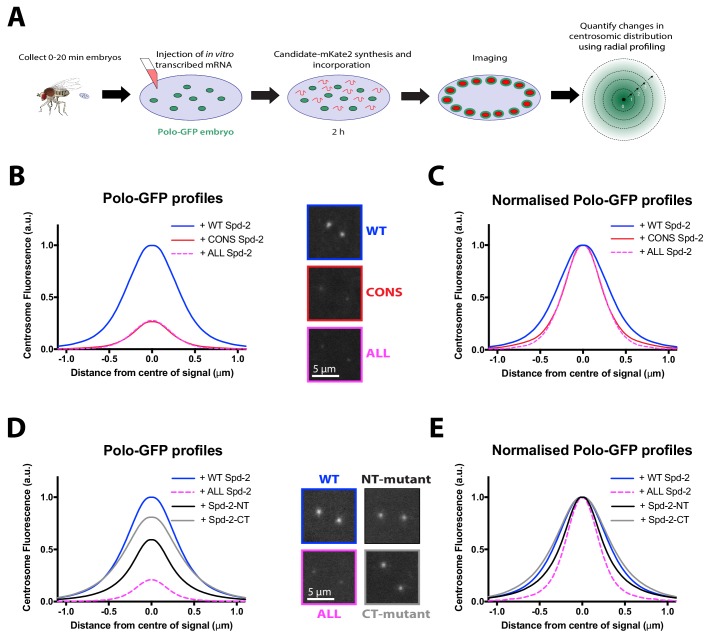
No single S-S/T motif in Spd-2 is essential for recruiting Polo to centrosomes.(A) Schematic illustration of the mRNA injection assay used to analyse the effect of various Spd-2-mKate2 fusion proteins on Polo-GFP recruitment. (B) Graph compares the radial distribution of Polo-GFP around the mother centriole in living WT embryos expressing Polo-GFP and injected with mRNAs encoding either WT Spd-2-mKate2, Spd-2-CONS-mKate2 or Spd-2-ALL-mKate2, as indicated; five centrosomes per embryo were analysed: n = 7, 6 and 9 embryos, respectively. Insets show examples of typical spinning disk confocal images used for this analysis. (C) Graph shows the same data as shown in (B), but normalised so that the peak intensity of all genotypes = 1. This emphasises how even if the centrosomal Polo-GFP signal is normalised for fluorescence intensity, Polo-GFP spreads out around the mother centriole to a lesser extent in the embryos expressing Spd-2-CONS-mKate2 or Spd-2-ALL-mKate2 than WT Spd-2-mKate2. These observations recapitulate our findings from transgenic lines expressing these Spd-2-GFP-fusions in a Spd-2 mutant background. (D,E) Same analysis as presented in panels (B,C), but analysing the distribution of Polo-GFP in embryos expressing either Spd-2-ALL-mKate2, or one of two versions of Spd-2 in which the potential Polo binding sites in either the N-terminal or C-terminal region of Spd-2 have been mutated, as indicated; five centrosomes per embryo were analysed: n = 13, 6, 13 and 10 embryos, respectively.10.7554/eLife.50130.041Figure 9—source data 1.Figure 9B,C source data; radial profie analysis (part 1).10.7554/eLife.50130.042Figure 9—source data 2.Figure 9B,C source data; radial profie analysis (part 2).10.7554/eLife.50130.043Figure 9—source data 3.Figure 9B,C source data; radial profie analysis (part 3).10.7554/eLife.50130.044Figure 9—source data 4.Figure 9B,C source data; radial profie analysis (part 4).10.7554/eLife.50130.045Figure 9—source data 5.Figure 9B,C source data; radial profie analysis (part 5).10.7554/eLife.50130.046Figure 9—source data 6.Figure 9D,E source data, radial profile analysis.